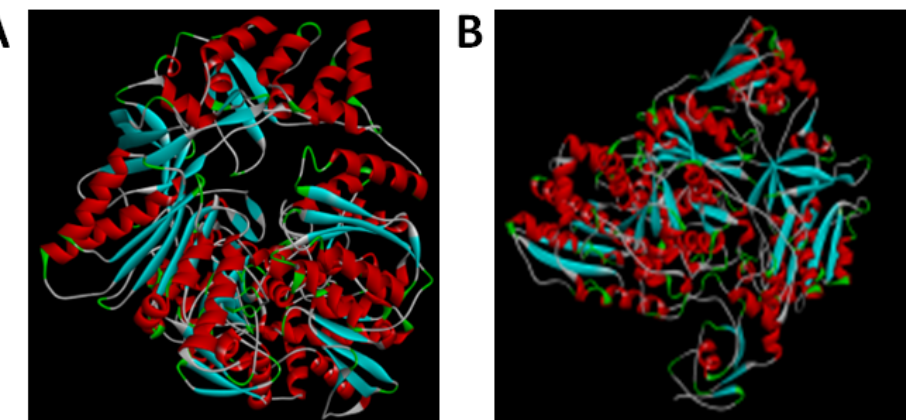
Figure 3. Phylogenetic analysis of TV NOS sequences and non-TV NOS. The phylogenetic evolutional relationship was calculated and depicted by Matlab. Two TV NOS were clustered together, marked by yellow. Note that the closest neighbors are four NOS sequences from A. flavus .